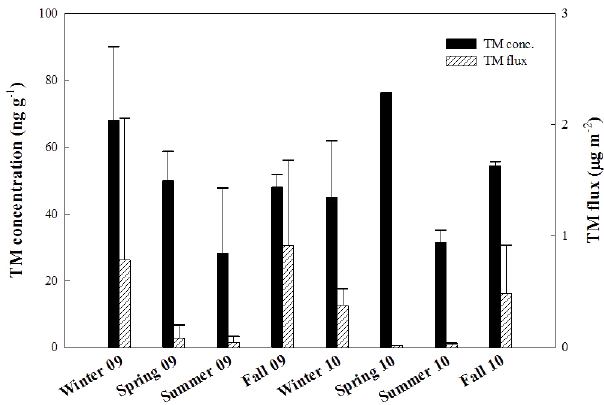
Figure 4. Seasonal variation in TM concentration and flux in a de- ciduous